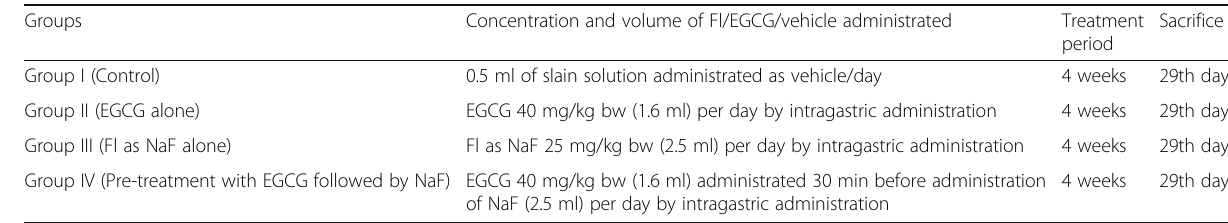
Table 1 The experimental design